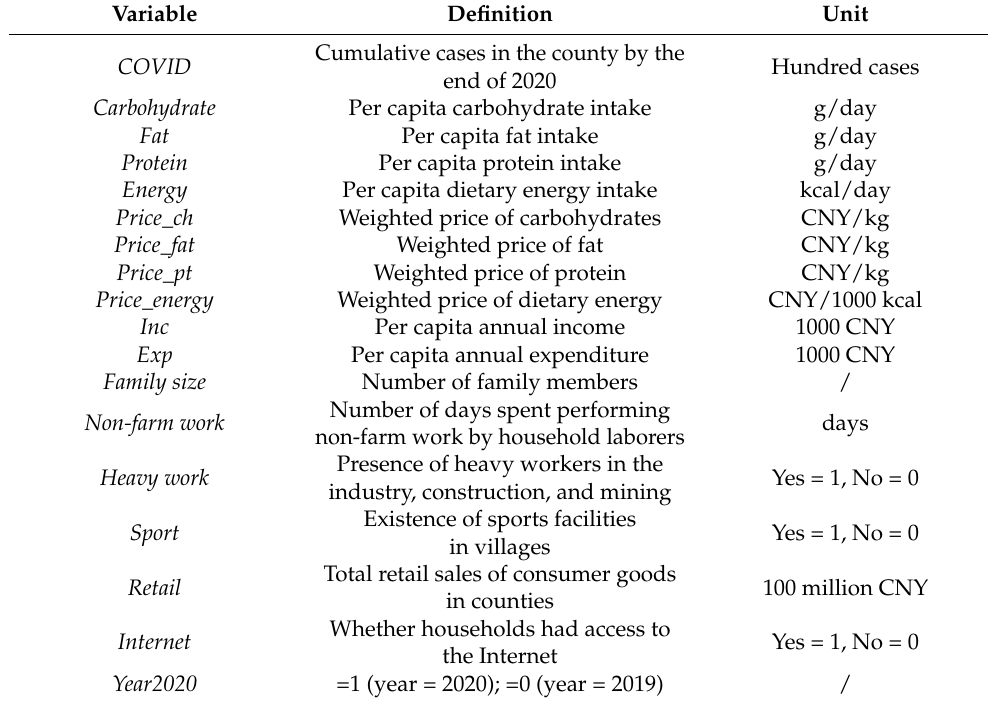
Table 1. Definitions of major